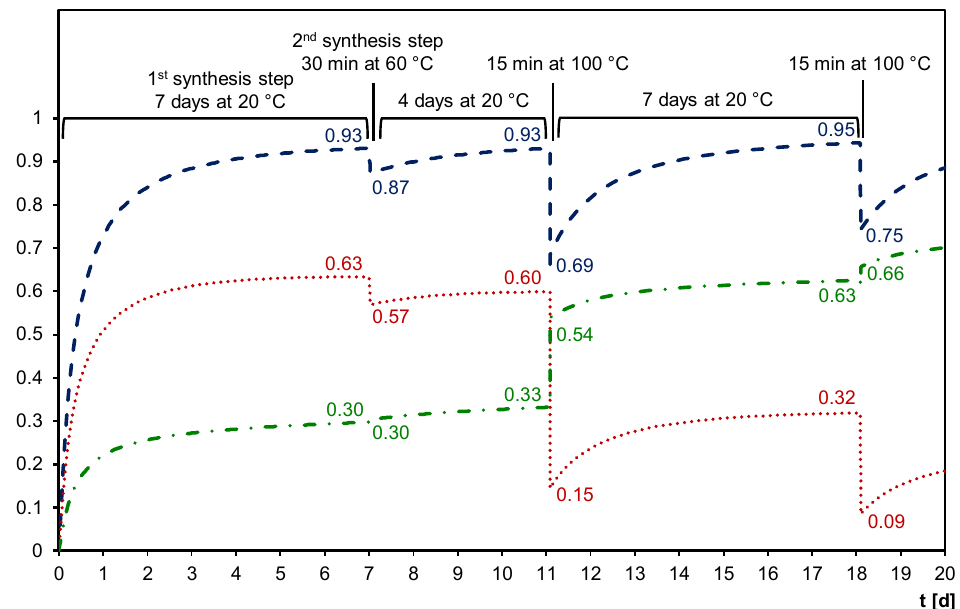
Figure 10. Simulated evolution of the Diels–Alder conversion for the formation of 3M-F375MA (first synthesis step, seven days at 20 ◦ C), the subsequent photopolymerization to form 3M-F375PMA (second synthesis step, 30 min at 60 ◦ C), a recovery period of four days at 20 ◦ C, the first heating to 100 ◦ C for 15 min, a recovery period for seven days at 20 ◦ C, and the second heating to 100 ◦ C for 15 min. Dashed blue line : total Diels–Alder conversion x ( = x endo + x exo ); Dotted red line : endo Diels–Alder adduct conversion x endo ; Dash-dotted green line : exo Diels–Alder adduct conversion x exo .